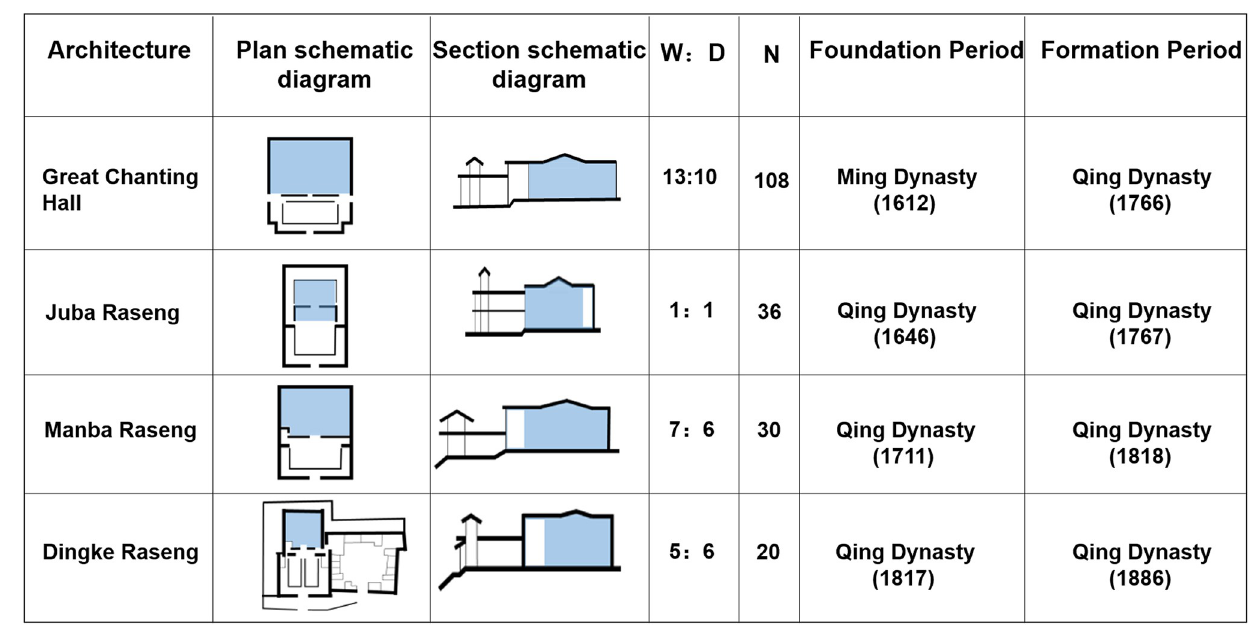
Fig 9. Spatial features of the palace buildings of type 3. (W, width of the Palace Halls; D, depth of the Palace Halls; N, the number of pillars).